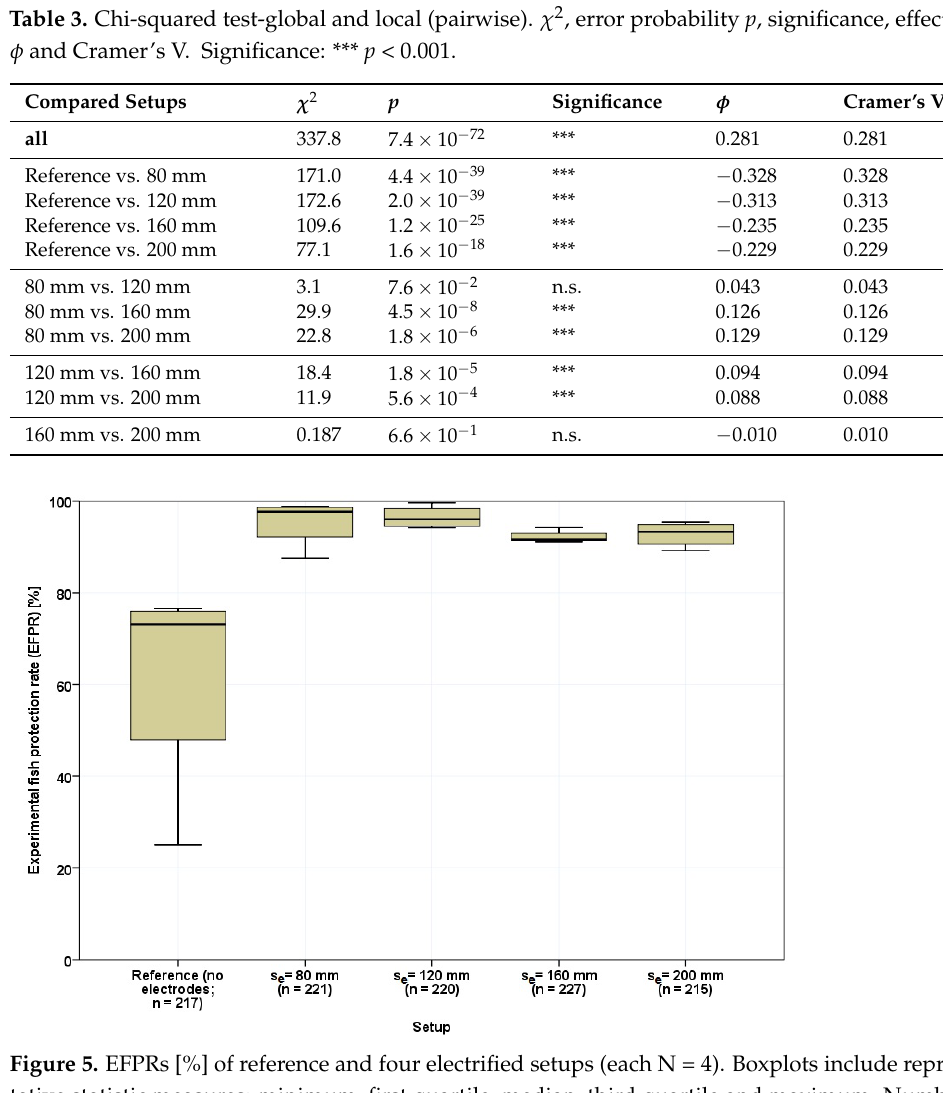
Figure 5. EFPRs [%] of reference and four electrified setups (each N = 4). Boxplots include represen- tative statistic measures: minimum, first quartile, median, third quartile and maximum. Number of participating individuals per setup and four trials (N = 4) is denoted